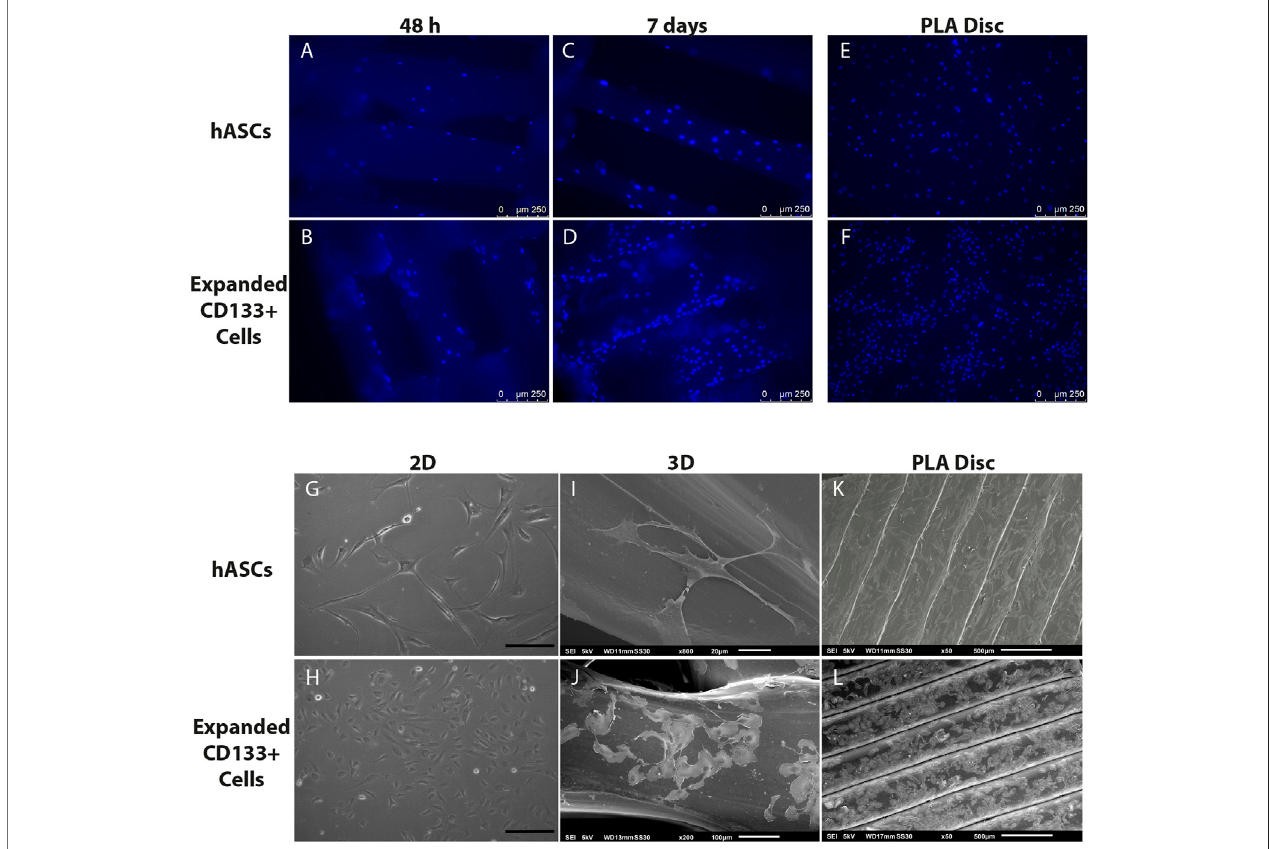
FIGURE 3 | Cell adhesion and morphology on the PLA scaffolds. Top panel: nuclear staining of the cells on the scaffolds. (A) hASCs adhered on the 3D scaffold after 48 h of culture. (B) Expanded CD133 + cells adhered on the 3D scaffold after 48 h of culture. (C) hASCs adhered on the 3D scaffold after 7 days of culture. (D) Expanded CD133 + cells adhered on the 3D scaffold after 7 days of culture. (E) hASCs and (F) expanded CD133 + cells adhered on the PLA disc. Bottom panel: phase contrast and SEM analyses ofcell morphology. (G) Characteristic morphology ofhASCson a 2D culture (H) Characteristic morphology ofexpanded CD133 + cells ona2Dculture(scalebar (cid:1) 200 µm) (I) hASCs ’ morphologyonthe3Dscaffold. (J) ExpandedCD133 + cells ’ morphologyonthe3Dscaffold. (K) hASCs ’ morphologyon the PLA disc. (L) Expanded CD133 + cells ’ morphology on the PLA disc. The images representing the 3D scaffolds were from the cultures on the S40, which presented the same pattern as the cultures on the